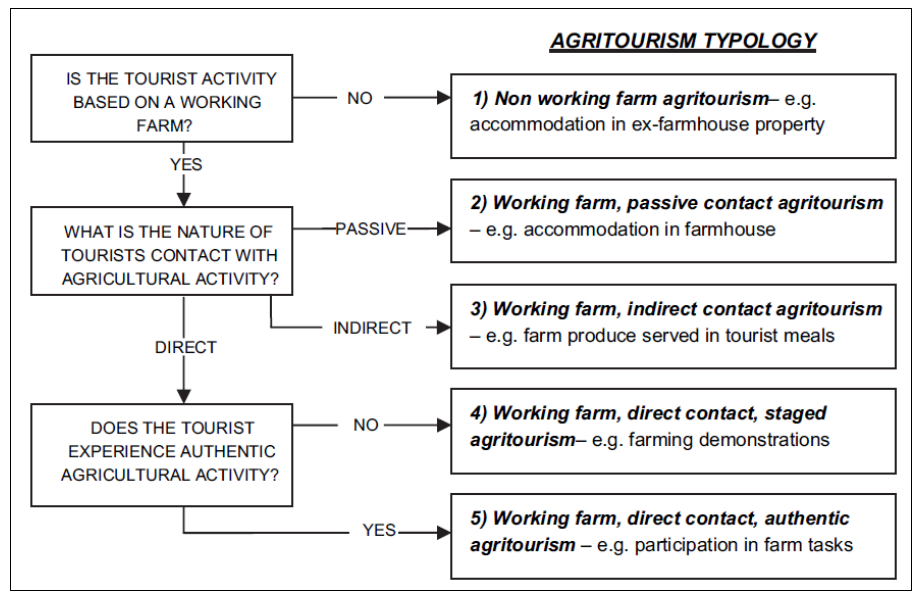
Figure 1. A Typology for Defining Agritourism